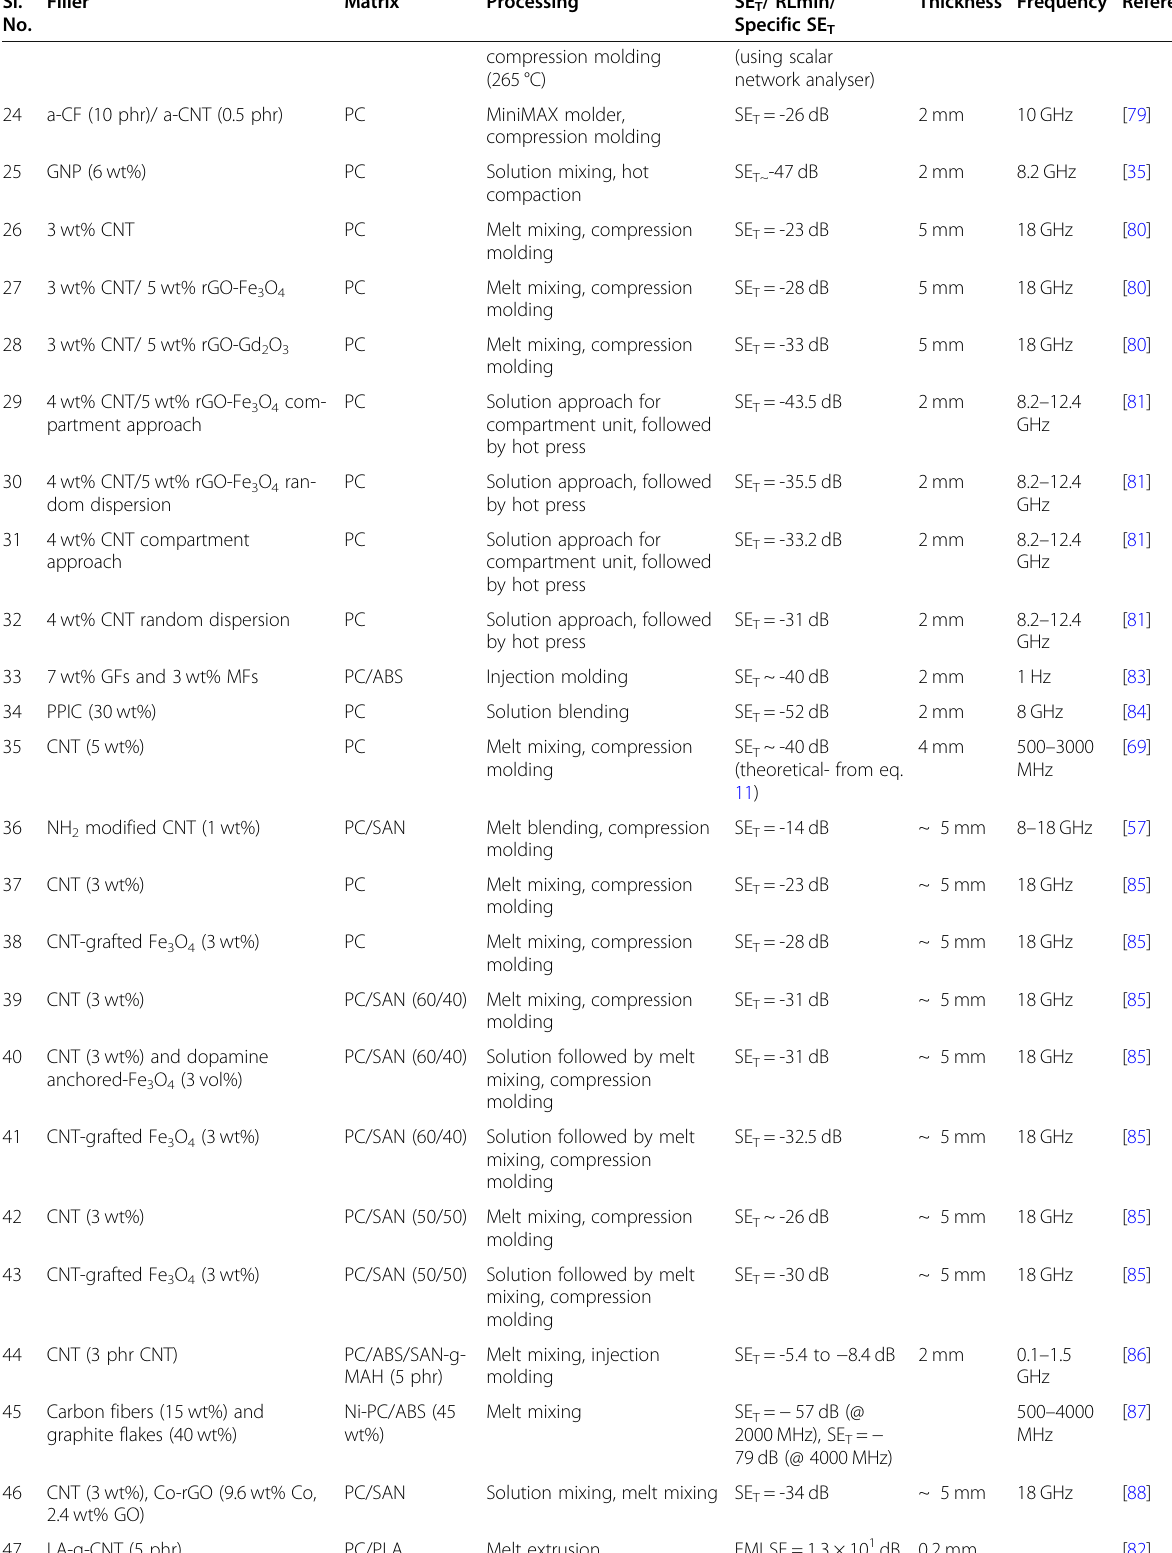
Table 4 List of PC-based hybrid structure for EMI shielding applications (Continued) Sl. No.